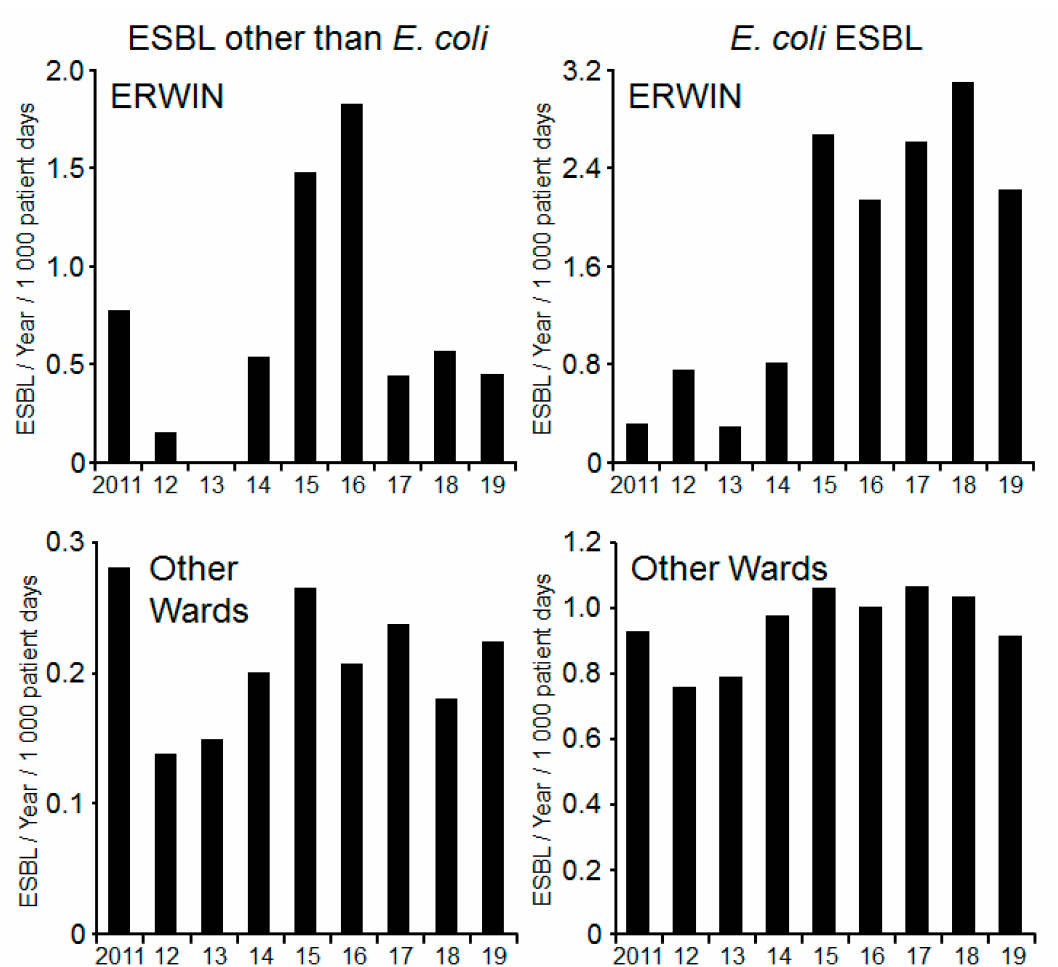
Figure 4. Number of patients colonized per 1000 patient days with extended spectrum beta-lactamase (ESBL)-producing Gram-negative bacteria at the Ingolstadt Hospital per year. Data were obtained from screening and clinical samples. Left panels : Other ESBL-producing species than Escherichia coli . Right panels : ESBL-producing E. coli . Upper panels : Patients on ERWIN. Lower panels : Patients on other